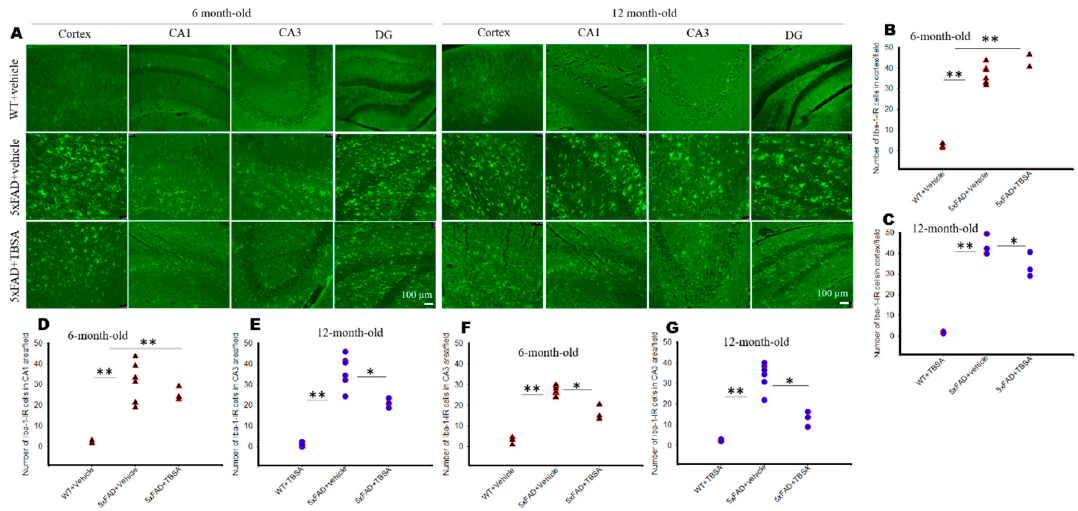
Figure 6. Treatments of trans-beta-styryl-boronic acid (TBSA) compound reduced microglial activation in the cortex and hippocampus in 5xFAD mice. Six- and twelve-month 5xFAD mice and age-matched wild-type mice were treated with TBSA for 2 months, sacrificed, and their brain sections were collected and immunolabeled for IBa-1. ( A ): representative images of Iba-1-IR in the cortex, CA1 and CA3 and dentate gyrus of hippocampus from 6- and 12-month-old mice. ( C – E ): The number of labeled Iba-1-IR (activated microglia) was significantly reduced in the cortex ( B , C ), CA1 area ( D , E ) and CA3 area ( F , G ) of hippocampus in comparison to vehicle-treated 5xFAD mice. Further reductions were observed in the case of the 12-month-old mice treatment group, compared with that of the 6-month-old group. Values are expressed as means ± SEM; scale bar = 100 µ m and is applicable to all images. * p < 0.05 and ** p < 0.01 in comparison to WT + Vehicle and 5xFAD + TBSA.